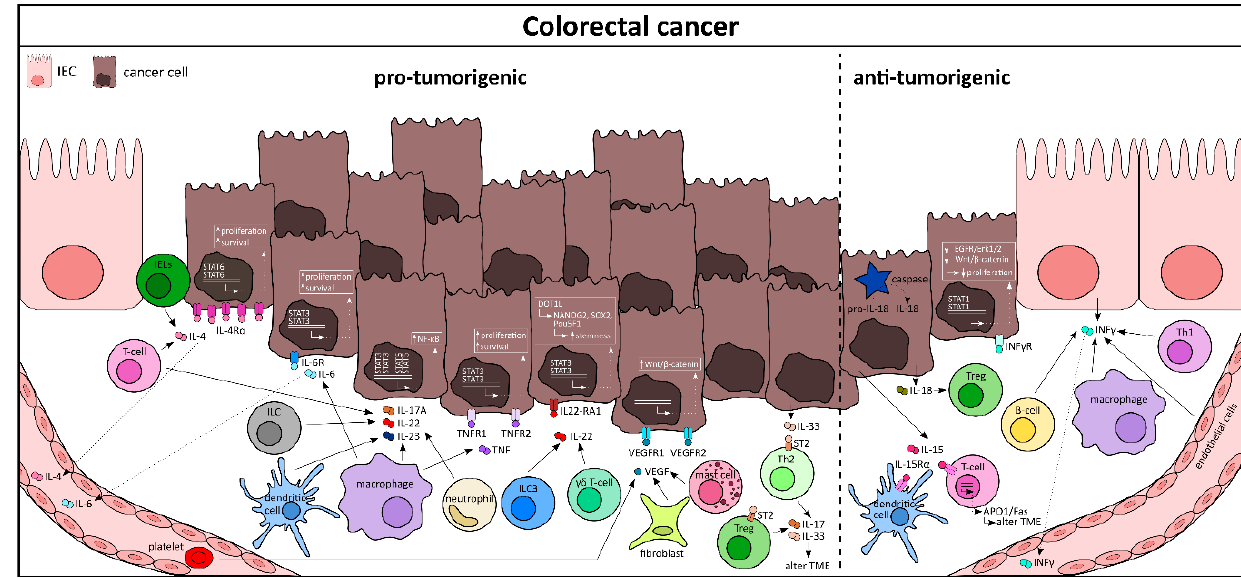
Figure 4. Cytokine signaling between intestinal epithelial cells and immune cells as a regulator of colorectal cancer development. TME, tumor microenvironment.